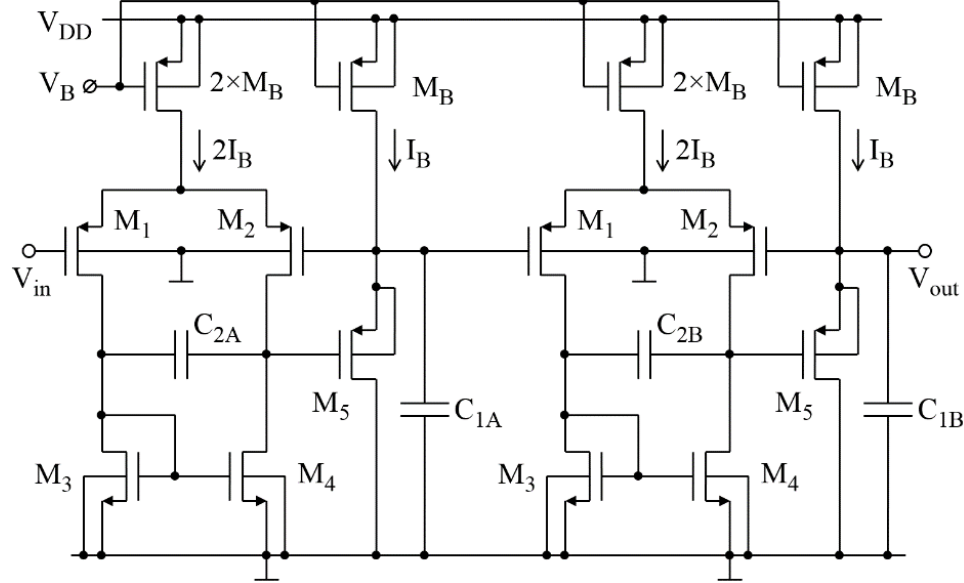
Figure 8. The 0.4-V, 100-Hz, fourth-order filter—the cascade of two biquads of Figure 5. C 1A = 7.10 pF, C 2A = 11.14 pF, C 1B = 17.10 pF, C 2B = 4.60 pF, and I B = 250 pA assuming Butterworth approximation and f − 3dB of 100 Hz.